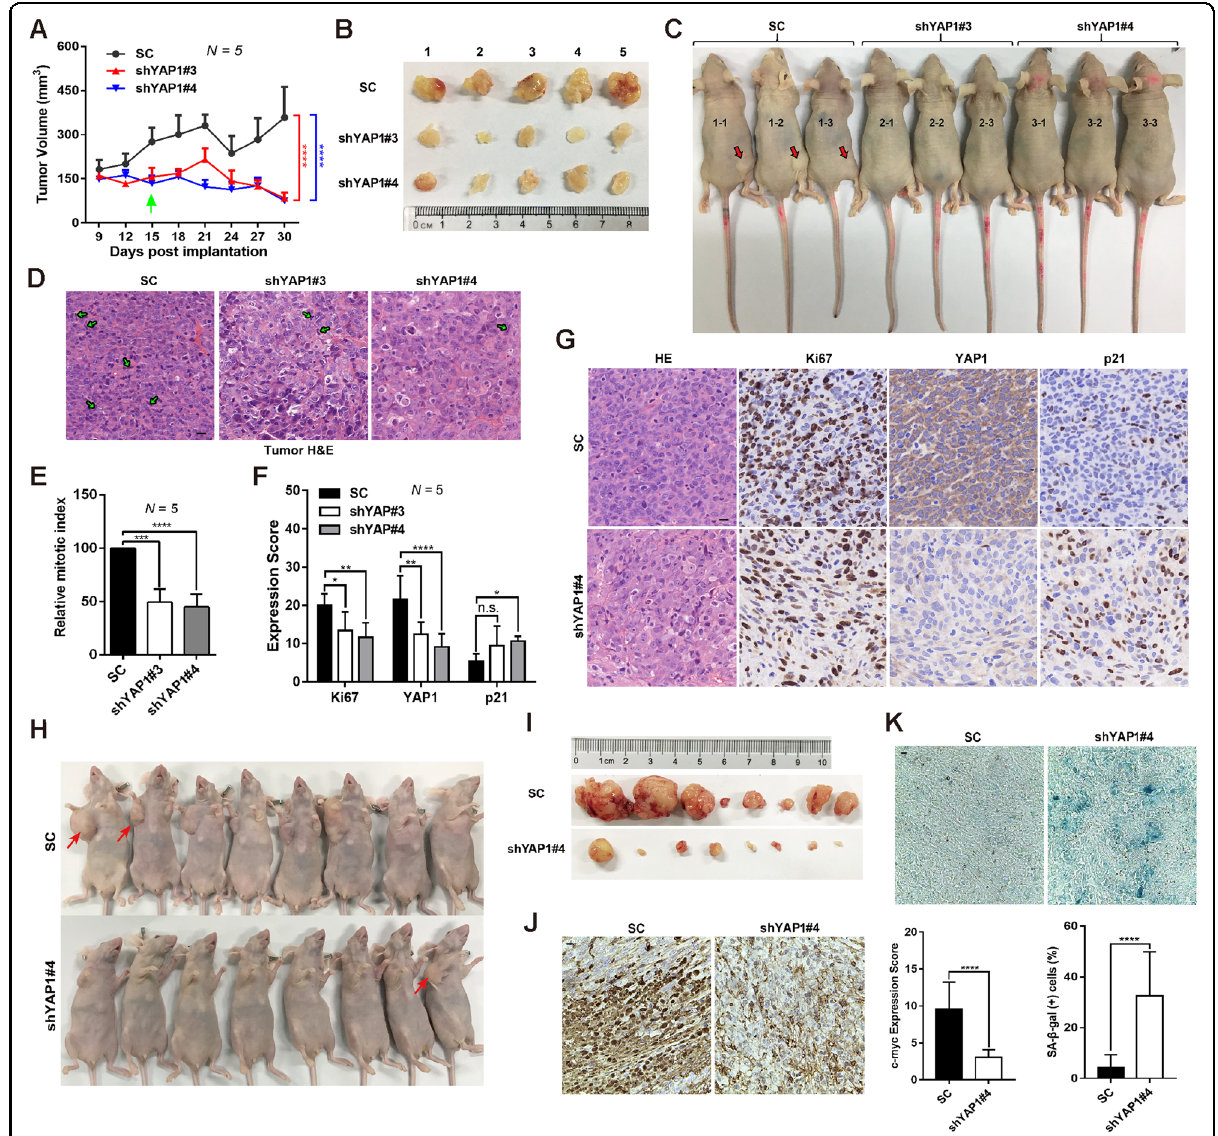
Fig. 3 YAP1 coordinates with p21 to control the growth of xenograft tumors. A – C YAP depletion inhibits xenograft tumor growth. control shRNA or YAP1-depleted SW 1353 cells were subcutaneously inoculated in the fl anks of nude mice. Nine days after injection, tumor growth curves were constructed based on the tumor volumes measured every 3 days ( A ); statistical signi fi cance was found 15 days post implantation. Ex vivo images of xenograft tumors at 30 days after dissection ( B ); in vivo images of representative nude mice ( C ). D , E YAP depletion suppresses xenograft tumor cell mitosis. Tumor sections were stained with H & E, arrows indicate mitotic cells ( D ), and the relative mitotic index was quanti fi ed ( E ), scale bars: 10 μ m. F , G YAP negatively regulates p21 expression in vivo. Tumor sections of ( B ) were stained with H&E or IHC for Ki67, YAP1, and p21 ( G ); the IHC scores for Ki67, YAP1, and p21 in the mouse tumor sections were measured ( F ), scale bars: 10 μ m. H , I SC and shYAP1#4 stable SW 1353 cells were subcutaneously inoculating into the nude mice at the right fl ank next to the forelimb for 57 days, the representative in vivo images of nude mice ( H ) and ex vivo xenograft tumors ( I ) were shown. J Tumor sections of ( I ) were stained with c-myc (left) and the IHC scores were measured (right). K Frozen sections of the fresh tumors were stained with SA- β -gal (above) and the percentage of SA- β -gal-positive cells were determined (below). Data are presented as the mean ± SD of at least three independent experiments in ( A , E , F , K ). One-way ANOVA followed by Dunnett ’ s test was applied for ( E , F ). Two-way ANOVA followed by Tukey ’ s test for ( A ). Student ’ s t -test for ( K ). n.s.: Nonsigni fi cant, * P < 0.05, ** P < 0.01, *** P < 0.001, **** P <